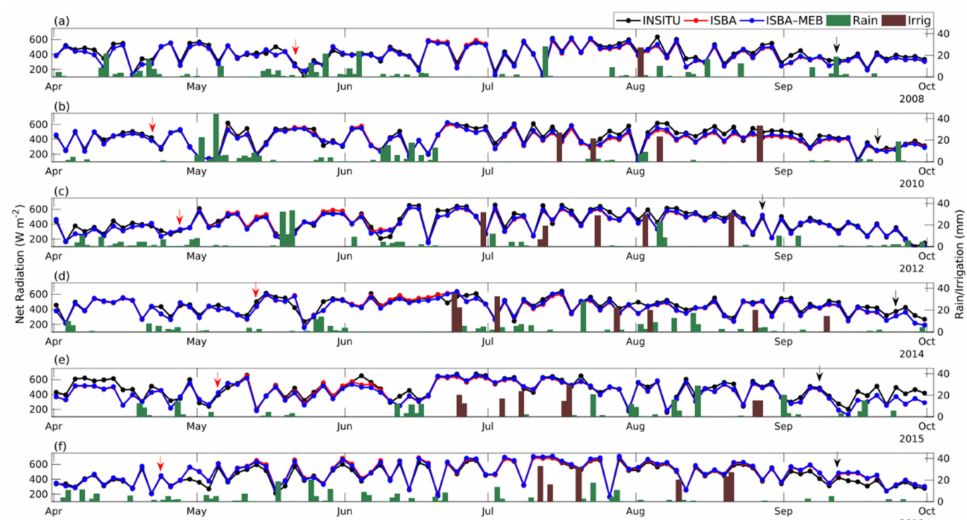
Figure 4. The 2-days average daytime series of the in situ net radiation (Rn) measurements (in black) with those estimated by ISBA (in red) and ISBA-MEB (in blue). Panels ( a – f ) represent the plots for 2008, 2010, 2012, 2014, 2015, and 2019, respectively. The red and black arrows signify the planting and the harvest days, respectively.